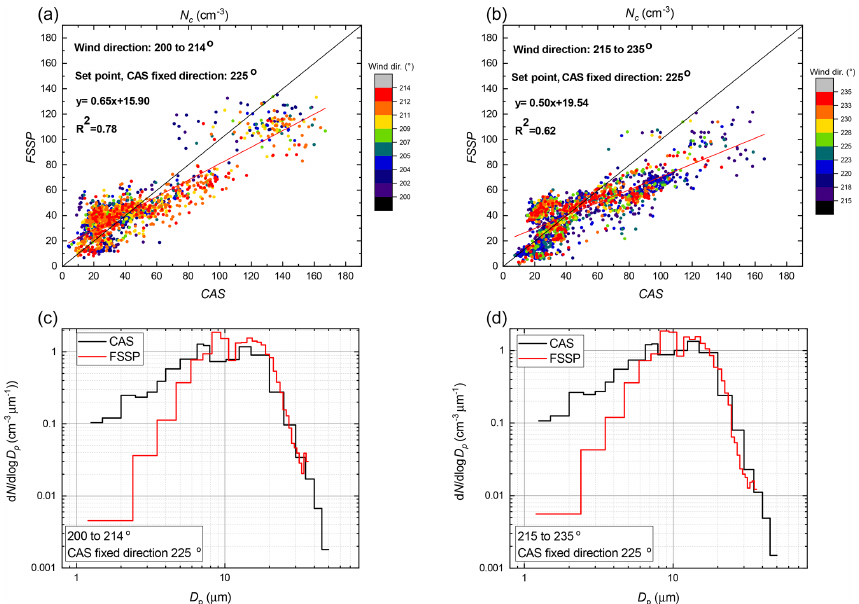
Figure 8. Comparison of number concentration ( N c ) as it was derived from the CAS and the FSSP is presented for two sectors of the wind rose while the station was inside a cloud: (a) 200 to 214 ◦ ; (b) 215 to 235 ◦ . Color code represents the wind direction. In (c) and (d) the size distribution as it was measured from the CAS probe and the FSSP for the same two wind sectors is